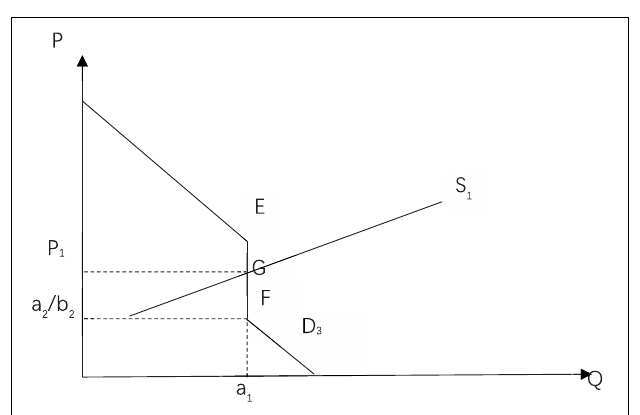
FIGURE 2 | Supply and demand balance for masks under a completely free market